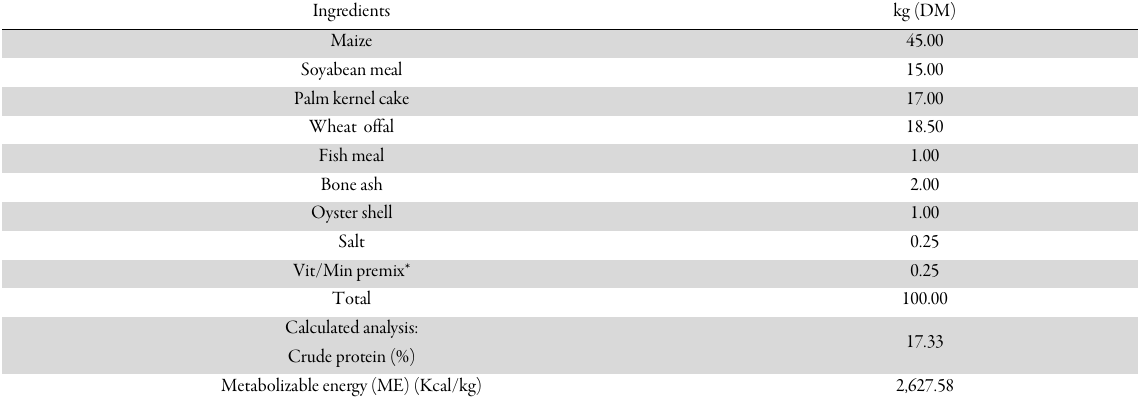
Table 1. Composition of growing rabbit’s diet fed administered with PGEs Ingredients